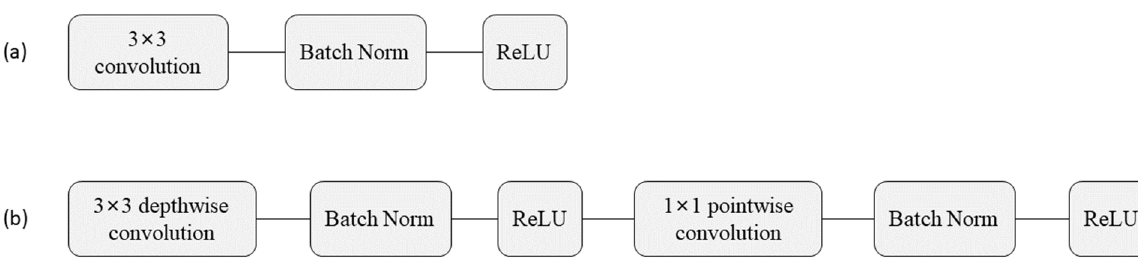
Figure 4. The convolution sequences in a standard layer. ( a ): normal convolution, ( b ): depth-wise separable convolution.